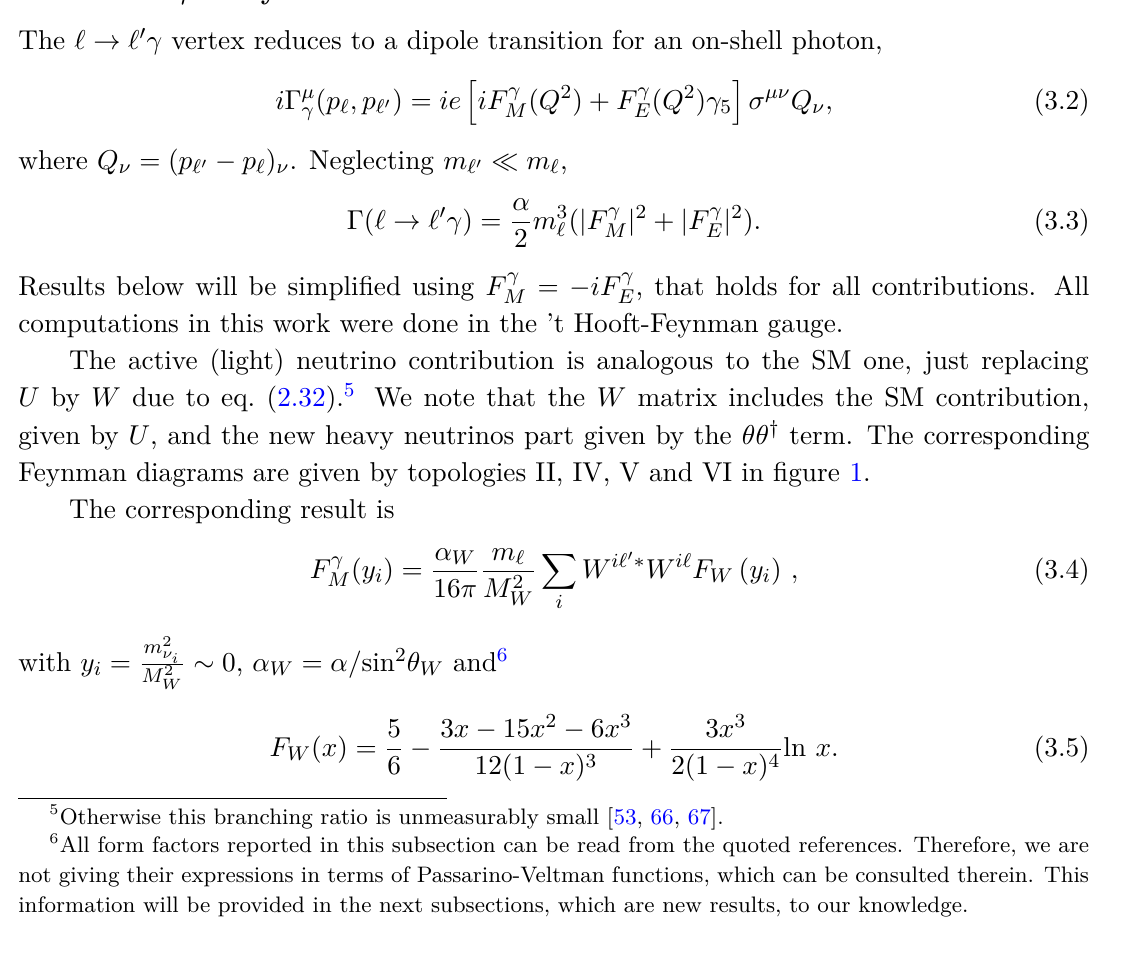
Figure 1 . Topologies of the diagrams that contribute to the ( γ/Z ) −